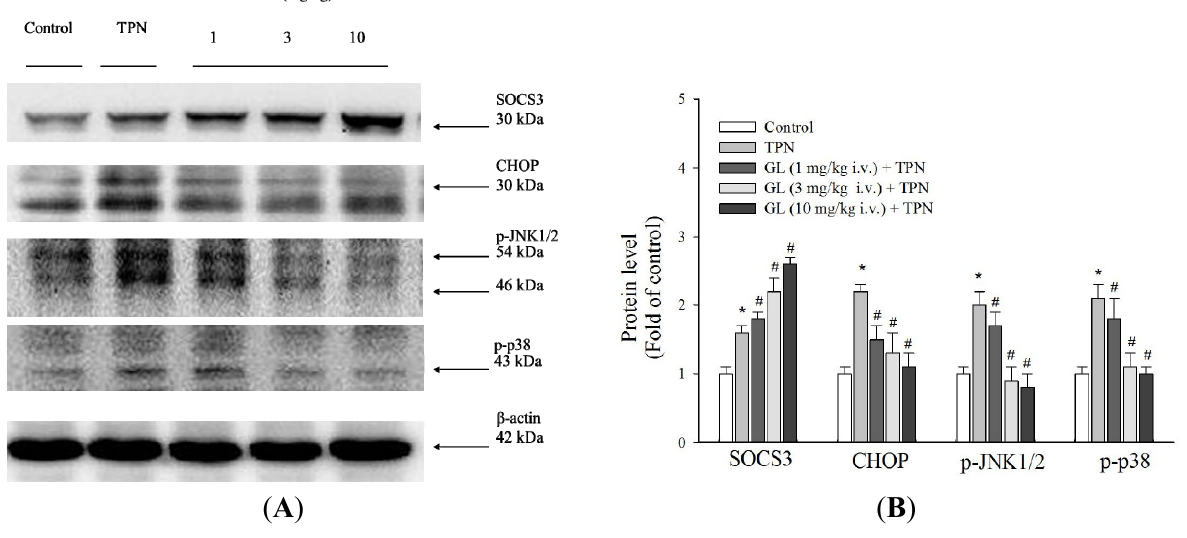
Figure 5. The effect of glycyrrhizin (GL) on liver histological SOCS3 and apoptotic pathway protein expression in rat livers. ( A ) Western blot analysis of proteins related to SOCS3 and the apoptotic pathway in the control, TPN and GL-pretreated groups; ( B ) SOCS3, CHOP and MAPK signaling protein expression were measured. The TPN group significantly increased SOCS3 protein expression, whereas SOC3 protein expression was decreased in the GL pretreatment groups. The phosphorylated of p38 MAPK and JNK proteins was increased in the TPN groups compared to the control and pretreatment groups. CHOP protein was also increased following TPN treatment. Equal amounts of protein from the total cell lysates of rat livers pretreated with GL were analyzed. β -actin served as an internal control. Protein levels were quantified using densitometric analysis and the control was set at 100%. The data depicted in bar graph are the mean ± SD of three independent measurements ( n = 6 in each group). * p < 0.05, compared with control group, # p < 0.05 between pretreatment groups and TPN